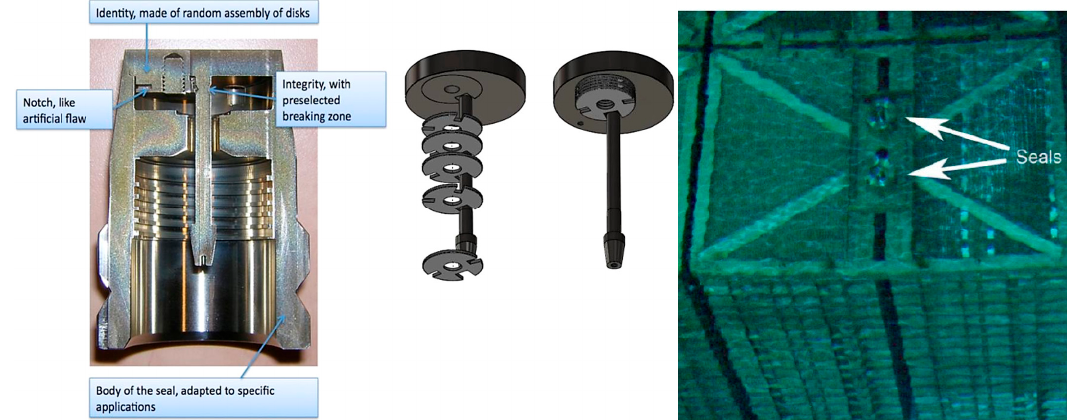
Figure 5. The Ultrasonic Sealing Bolt (USSB) structure and its application on underwater storage casks for nuclear items.